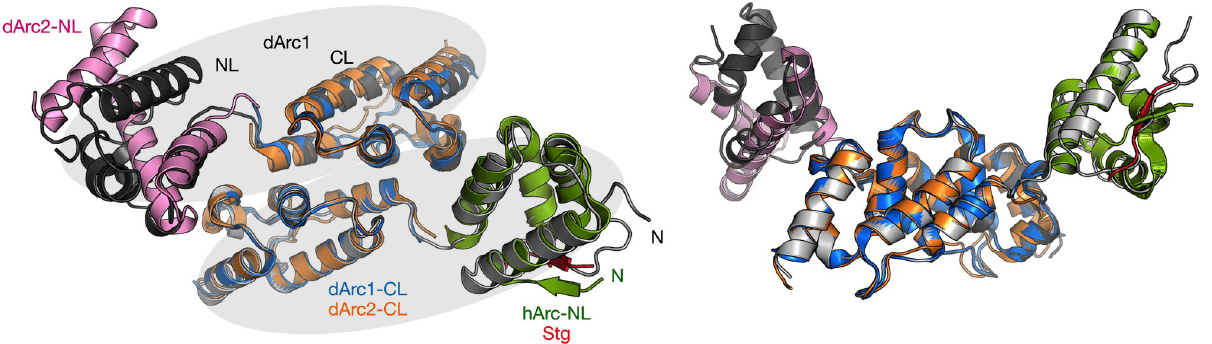
Fig 8. Comparison to the dArc1 crystal structure. Left: top view of the dArc1 dimer (gray); the two monomers are highlighted by ellipsoids in light gray. The superposed structures on the CL dimer and the two NL domains are indicated, and include dArc2-NL monomer (pink; this work), dArc1-CL dimer (blue; this work), dArc2-CL dimer (orange; this work), and hArc-NL (green) complexed with the Stg ligand peptide (red) [17]. Right, the same structures viewed from the side of the dArc1 dimer.